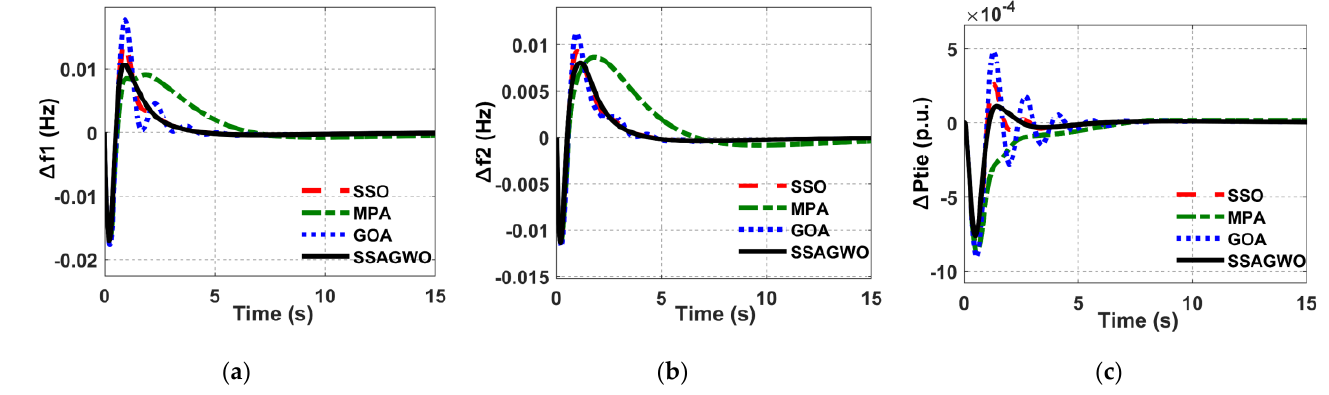
Figure 11. The frequency deviation responses and change in tie line power of SSAGWO compared with GOA, MPA, and SSO for tuning PID controller parameters for case I: ( a ) The frequency deviation of area 1; ( b ) The frequency deviation of area 2; ( c ) The power deviation of the tie line.